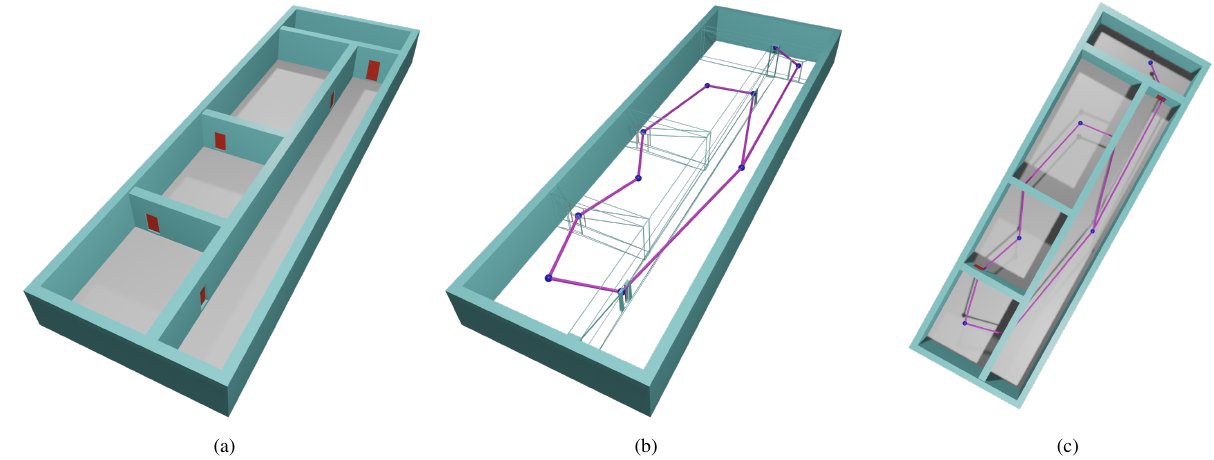
Figure 1. (a) The indoor space subdivided into 4 rooms and one corridor, and 5 doors in red. (b–c) The navigation graph in purple.